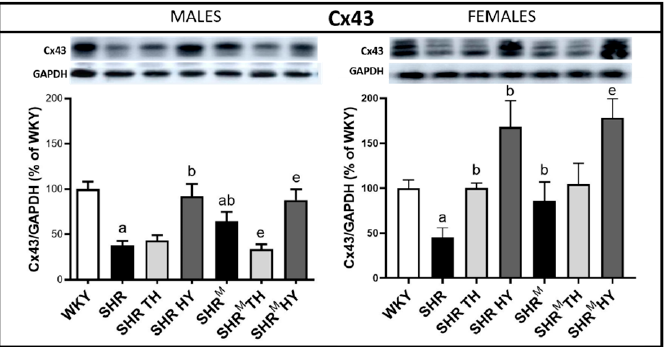
Figure 5. Myocardial protein levels of Cx43 assessed by Western blots. Note the significant de- crease of the Cx43 levels in the hypertensive strains compared to normotensive WKY but, to a lesser extent, in hairless SHR M males and females. The hypothyroid status enhanced the Cx43 protein levels in both SHR strains. WKY—Wistar Kyoto normotensive control rats, SHR—wild type sponta- neously hypertensive rats, TH—hyperthyroid rats, HY—hypothyroid rats and SHR M —hairless spon- taneously hypertensive rats, n = 5 per group. Data are presented as means ± SD, a p < 0.05 vs. WKY, b p < 0.05 vs. SHR, e p < 0.05 vs. SHR M . One-way ANOVA and Bonferroni’s multiple comparison test were used as the statistical